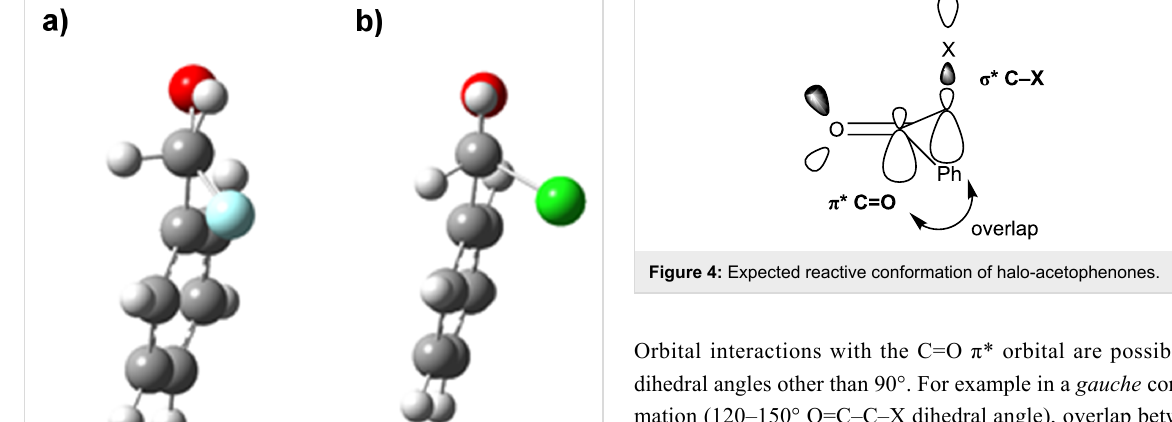
analogues, suggesting that it will be energetically unfavourable for α -fluoroacetophenone to access these particularly reactive conformations.